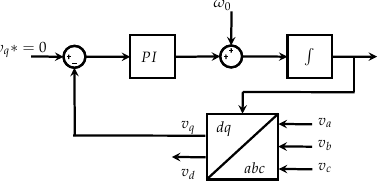
Figure 3. Block diagram of Phase-Locked Loop (PLL).